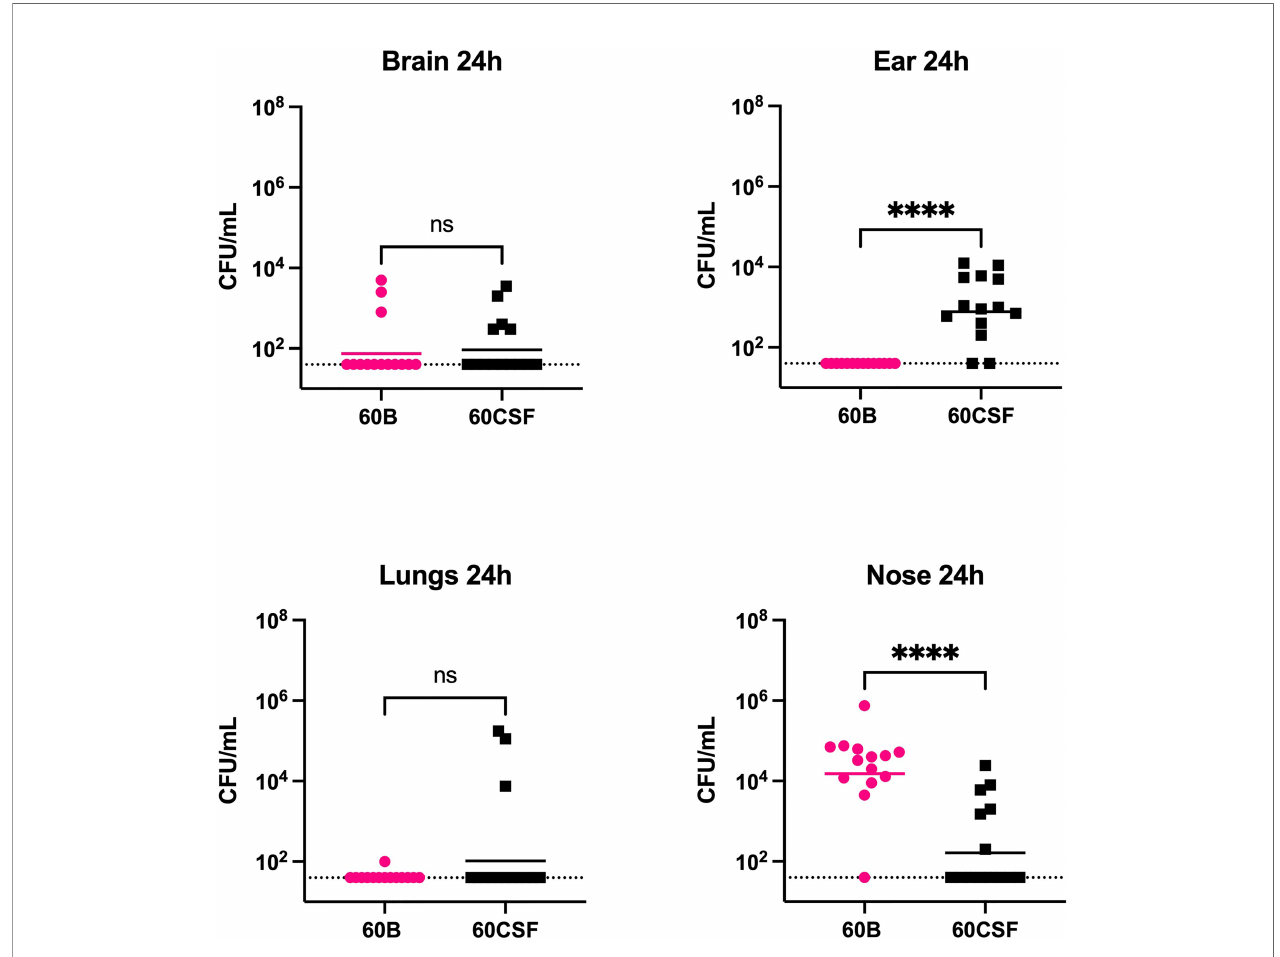
FIGURE 5 | Virulence phenotypes of blood and CSF isolates. In 2 separate experiments groups of 6 or 8 mice were infected intranasally with 10 8 CFU of the indicated strain. At 24 h, mice from each group were humanely euthanized and pneumococci in the brain, ear, lungs and nasal tissue were enumerated. Viable bacterial counts are displayed for each mouse in each niche; horizontal bars indicate the geometric mean (GM) CFU for each group; the dotted line indicates the detection threshold. Signi fi cance of differences in bacterial load between groups was determined using two-tailed Student ’ s t test; **** P < 0.0001. ns, not signi fi